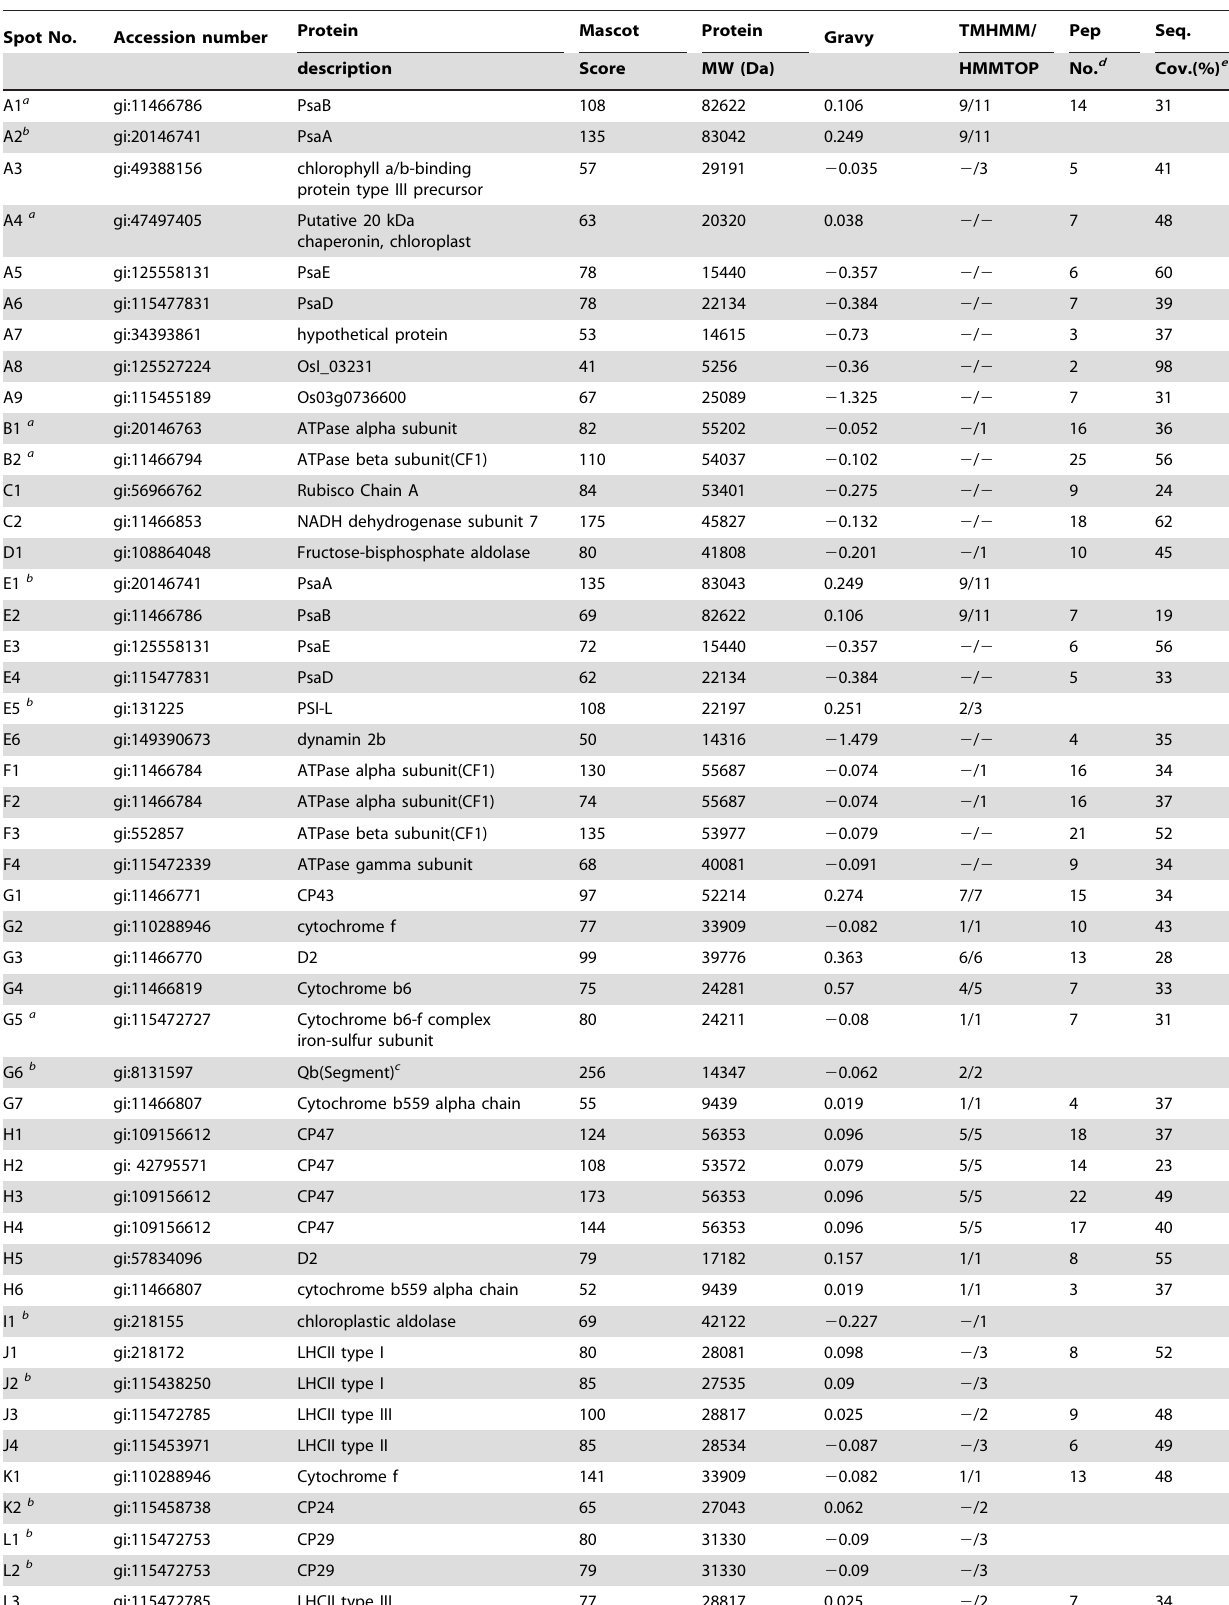
Table 2. Identification of thylakoid membrane proteins in rice ( Oryza sativa L.) by MALDI-TOF.